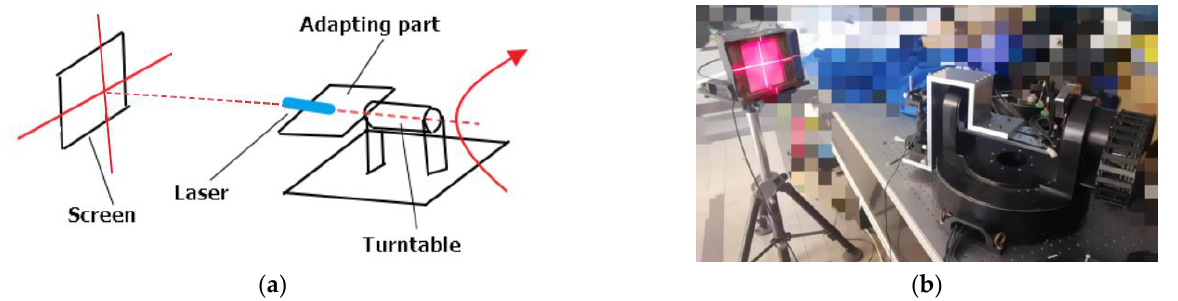
Figure 17. (a) Schematic diagram of the experiment. (b) Procedure picture of the experiment. Figure 17. ( a ) Schematic diagram of the experiment. ( b ) Procedure picture of the